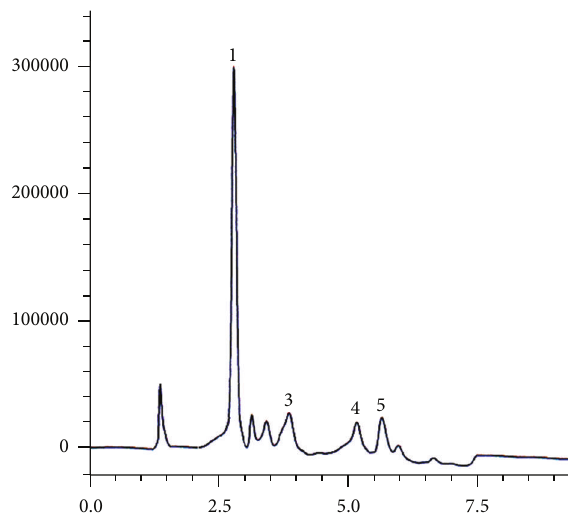
Figure 5: HPLC analysis of methanolic extract of C. zeylanicum (2 = gallic acid, 3 = catechin, 4 = hesperidin, 6 = quercetin, and 7 = cinnamic